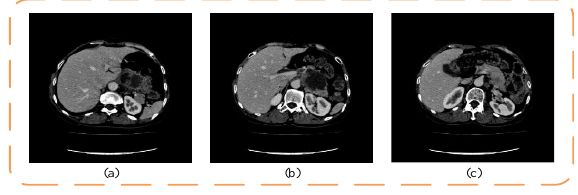
Figure 4. Three CT datasets: (a) I, (b) II, (c) III.